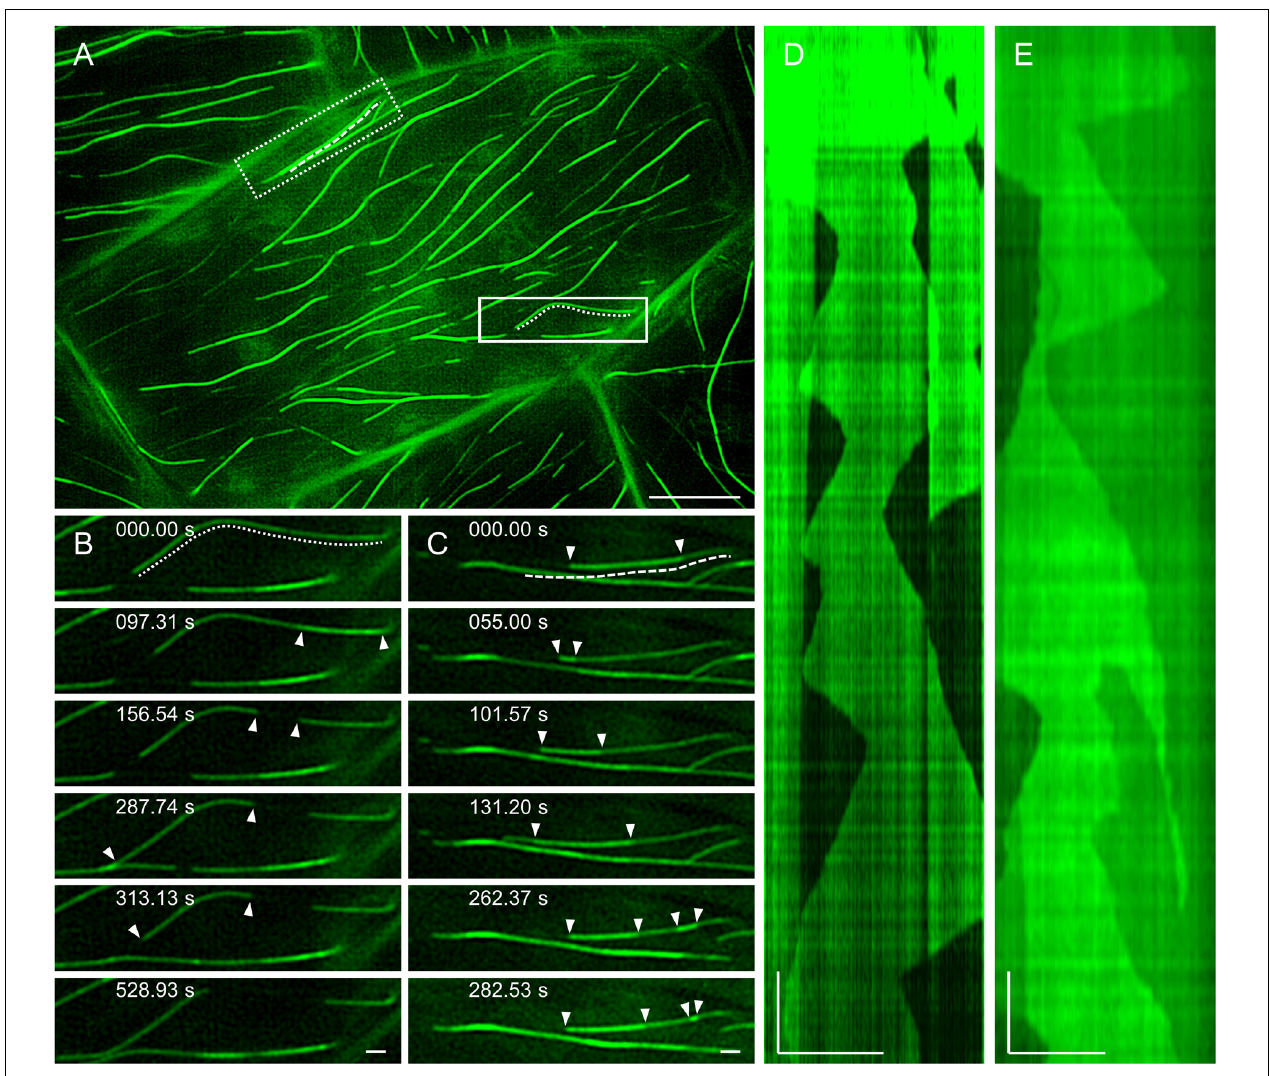
FIGURE 8 | MAP65-2 dynamics (see also Supplementary Video S2 ). (A) An overview of a hypocotyl epidermal cell of stably transformed line expressing eGFP-MAP65-2 observed by 2D-SIM (objective 63 × /1.40 NA). In full-line box is area, which is magnified in stills in (B) and the dotted line marks microtubule bundle used for generating kymograph (D) ; while in dotted-line box is area depicted in stills in (C) , with dashed line next to microtubule bundle used for generating kymograph in (E) . Stills in (B) show growth of an individual microtubule bundle as is demonstrated on a kymograph (D) . Complex dynamics within composite microtubule bundle are demonstrated in stills (C) and a corresponding kymograph (E) ; white arrowheads point to microtubule ends. Scale bars = 10 µ m (A) , or 1 µ m (B–E) . Time bars = 1 min (D,E)